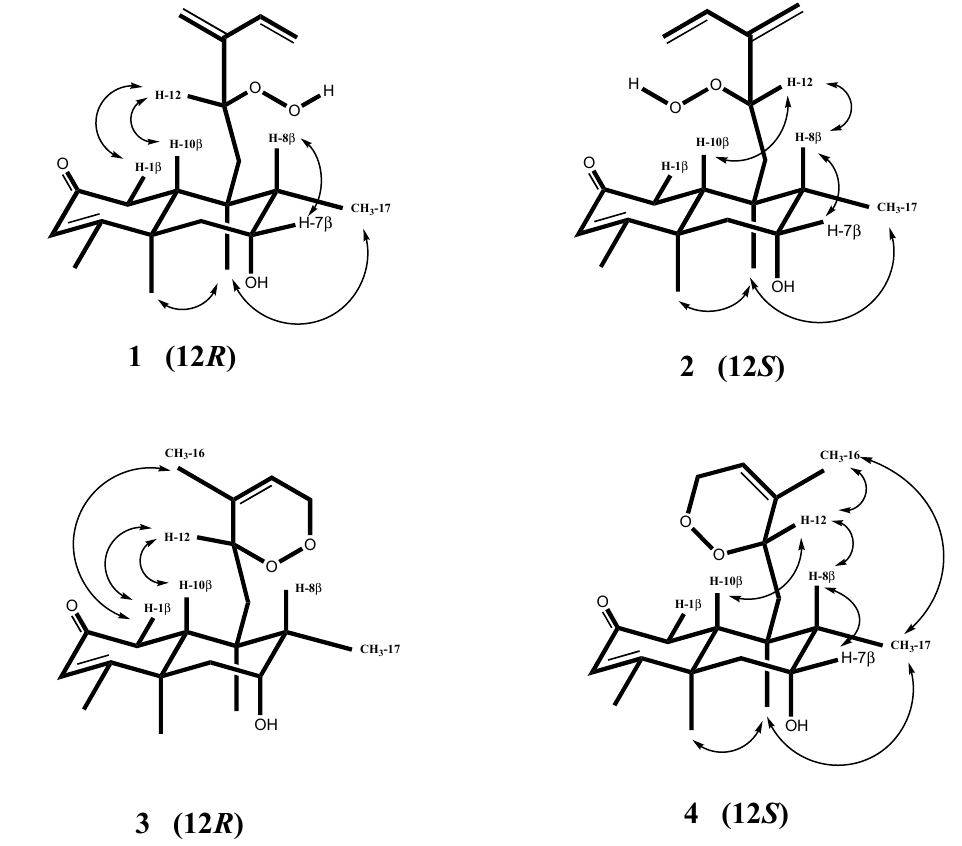
Figure 3. Stereo configurations based on NOESY correlations and 3D molecular model for 1 – 4.